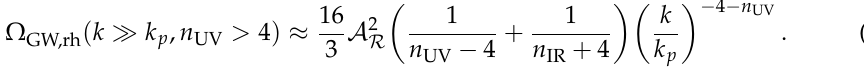
k p and k k p . They even give a good order of (cid:28) (cid:29) k p ∼